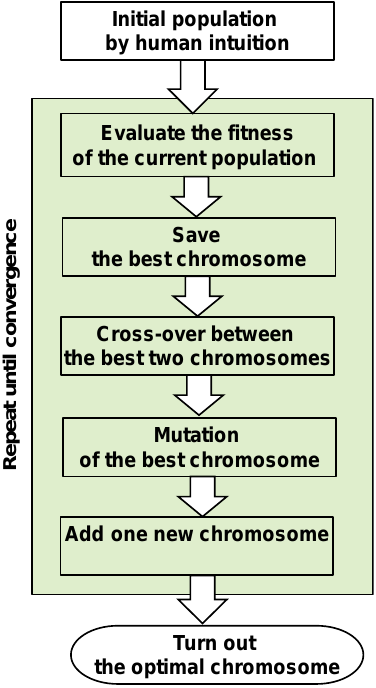
Figure 4. The algorithmic flow to the optimal dummy pattern by the genetic algorithm.